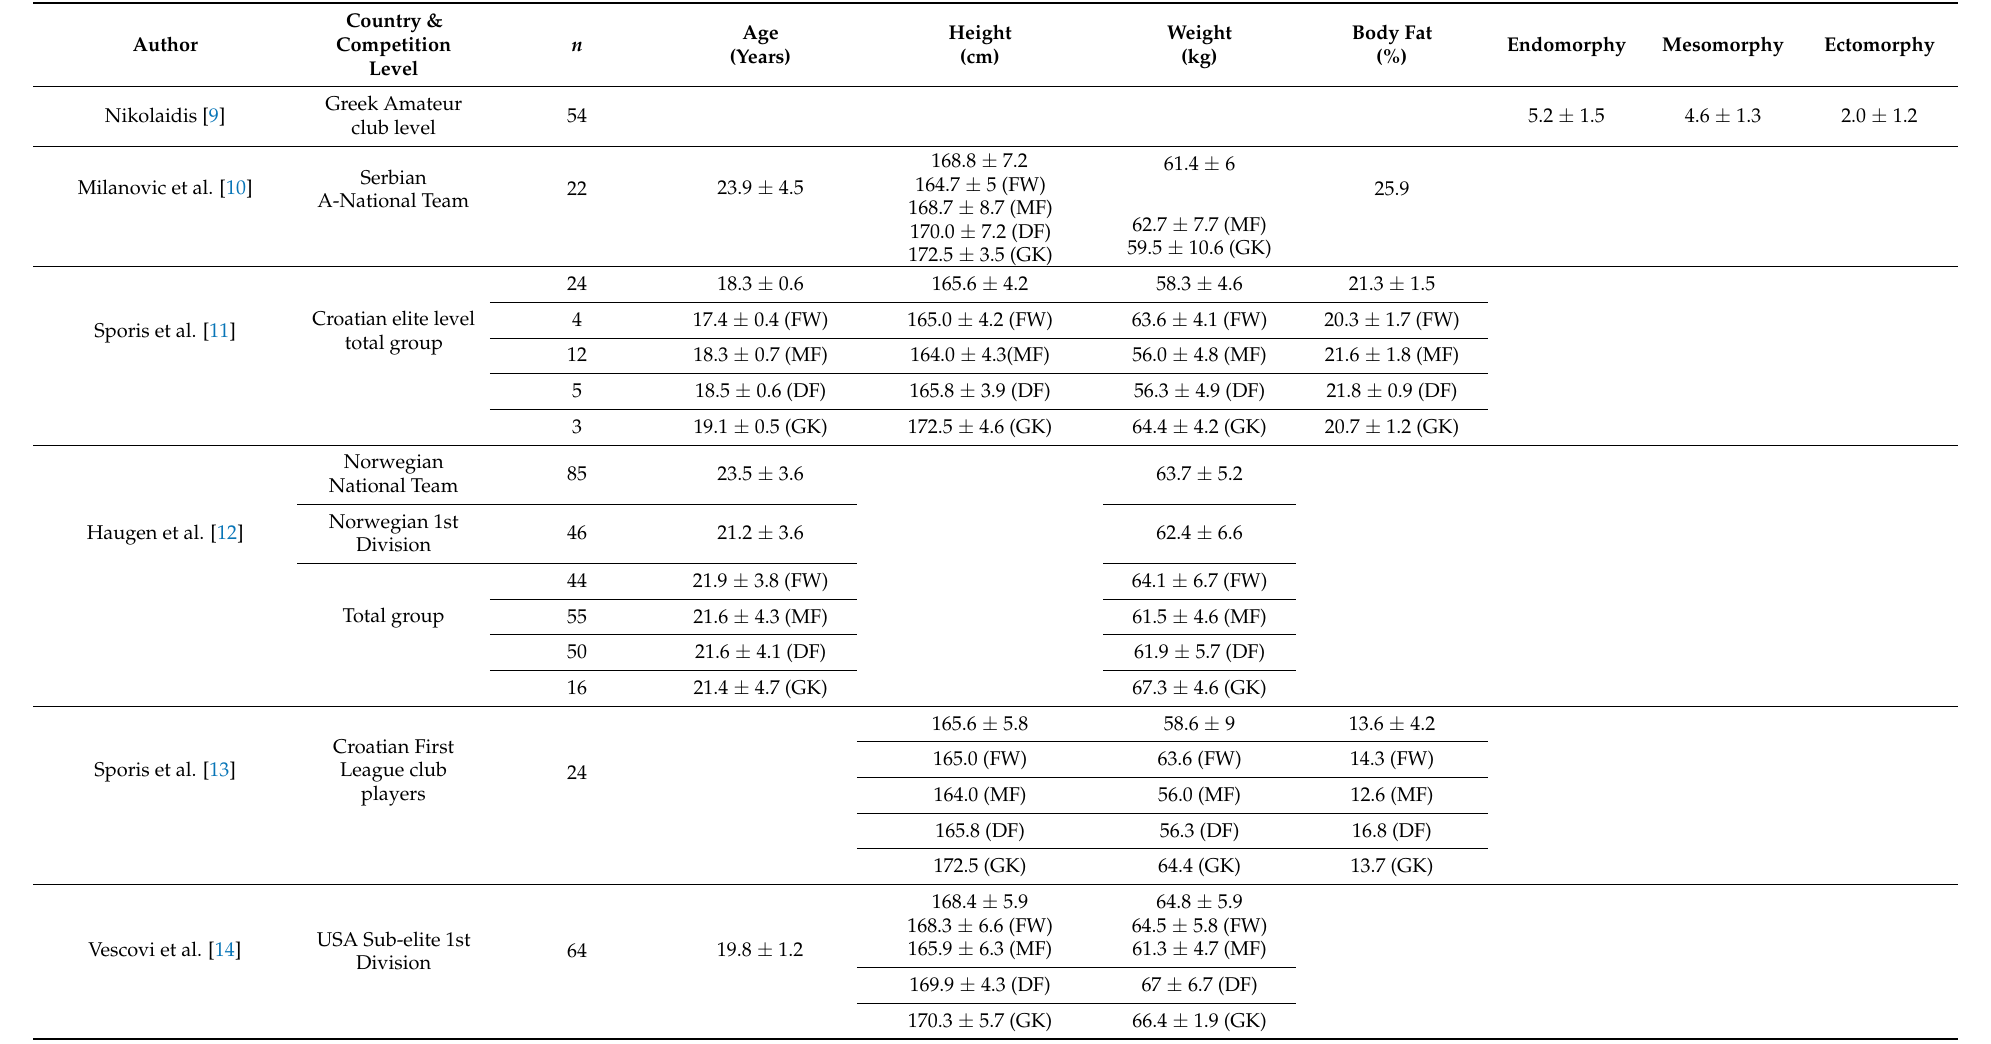
Table 4. Summary table of studies examining differences between position in age, height, weight, %BF and somatotype of adult female football players (mean ±